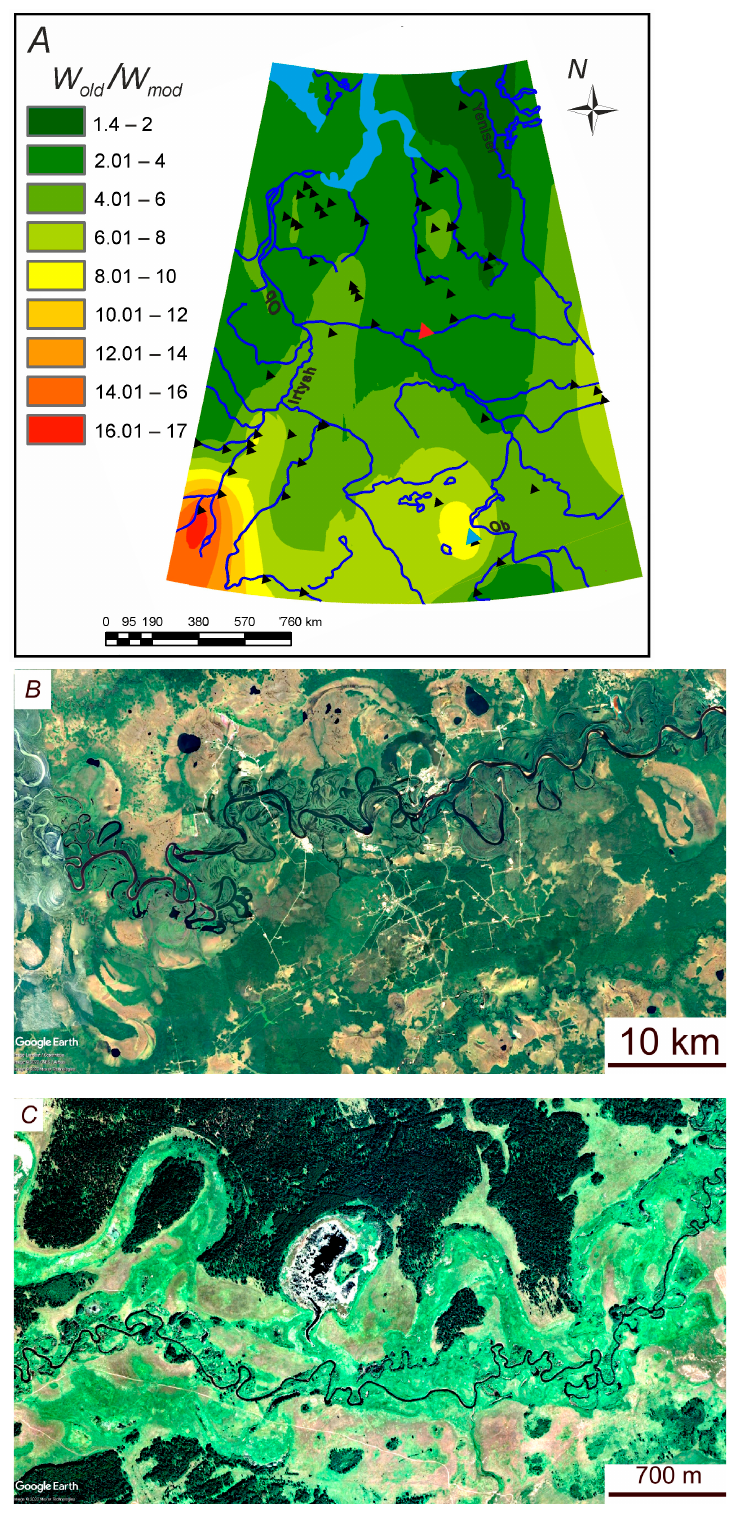
Figure 3. ( Panel A ): The ratios of the widths of large paleochannels ( W old , m) and modern channels ( W mod , m) within the same stretches of river valleys (Table S1); positions of the sites are indicated by black triangles. Typical examples of large paleochannels: for the northern part of the West Siberian Plain—the Vakh River ( B ), index 67 in Figure 1, red triangle in ( A ); for the southern part of the plain—the Kulunda River ( C ), index 166, blue triangle in ( A